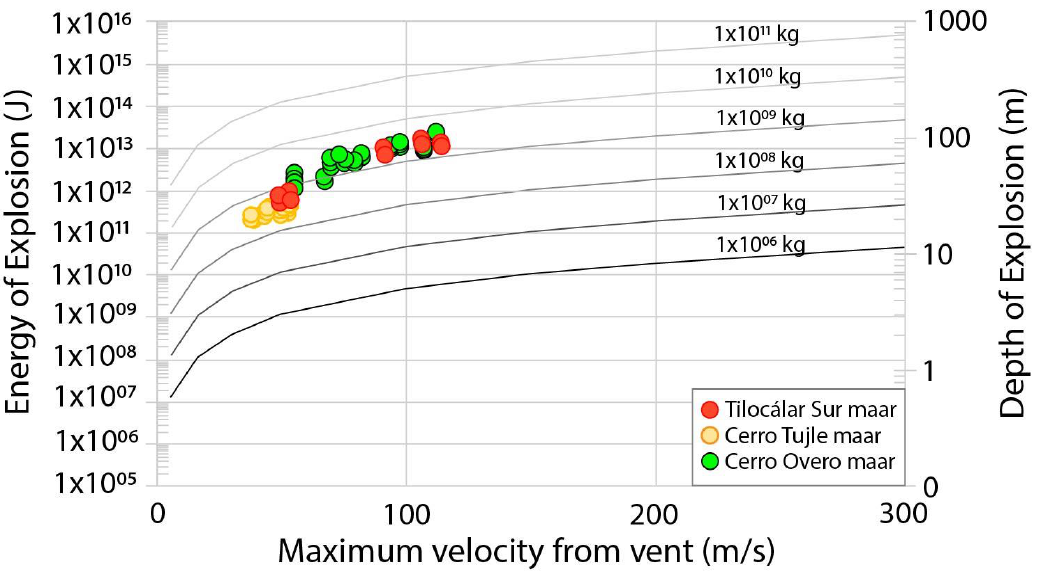
Figure 6. Plot of ejection velocity, the energy of the explosion, and the physical depth of explosion [93] for near-optimal scaled depth explosions for a range of ejected masses estimated from Valentine, et al. [92] (by gray lines). Data taken from Ureta, et al. [53], Ureta, et al. [50], and Ureta, et al. [54].